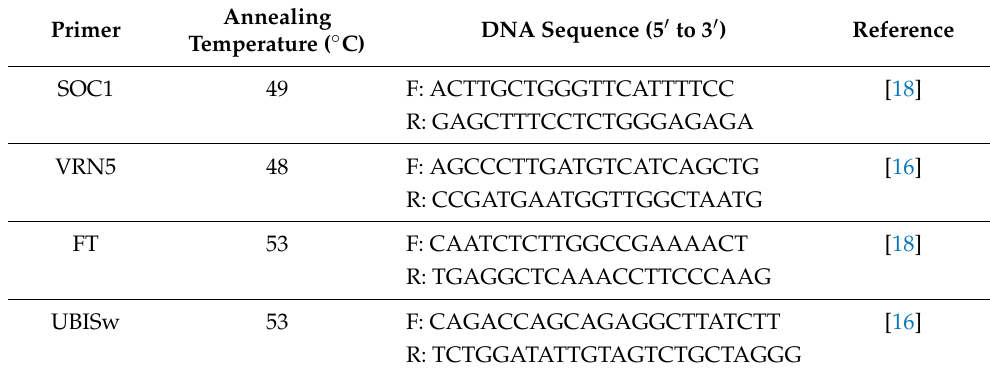
Table 1. Primer used for expression study of SOC1, VRN5, FT and UBISw genes. Annealing Primer Temperature ( ◦